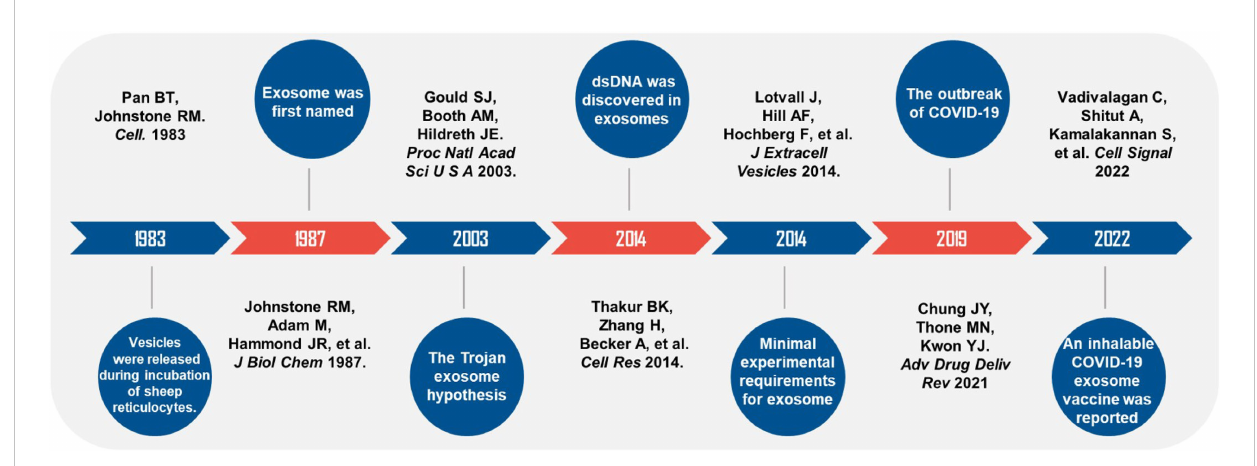
FIGURE 2 Timeline of studies on exosomes and viral infections. Black handwriting shows the author and the journal. Major events were described in white handwriting.